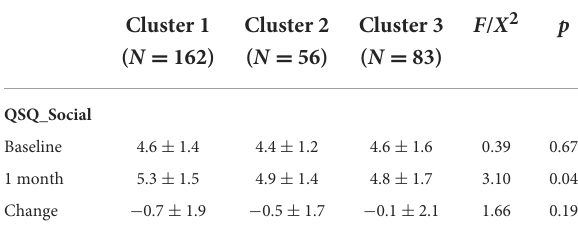
TABLE 5 Sleep-related health issues at baseline and 1 month among three clusters.